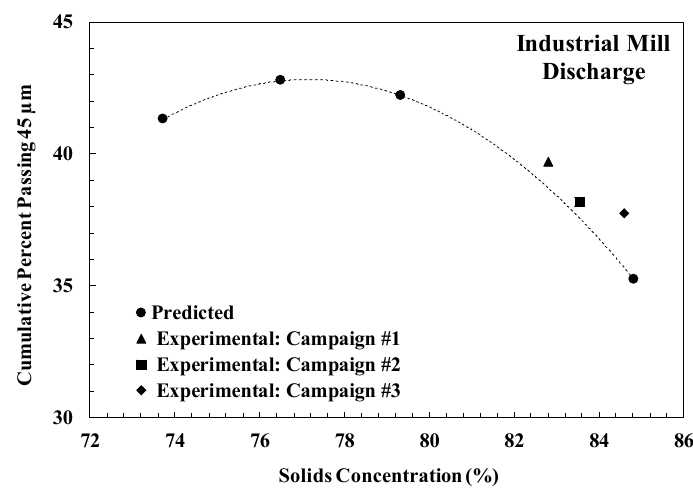
Figure 17. Cumulative passing in 45 µ m of industrial mill discharge as a function of solids concentration—predicted and experimental results from industrial campaigns #1, 2, and 3.